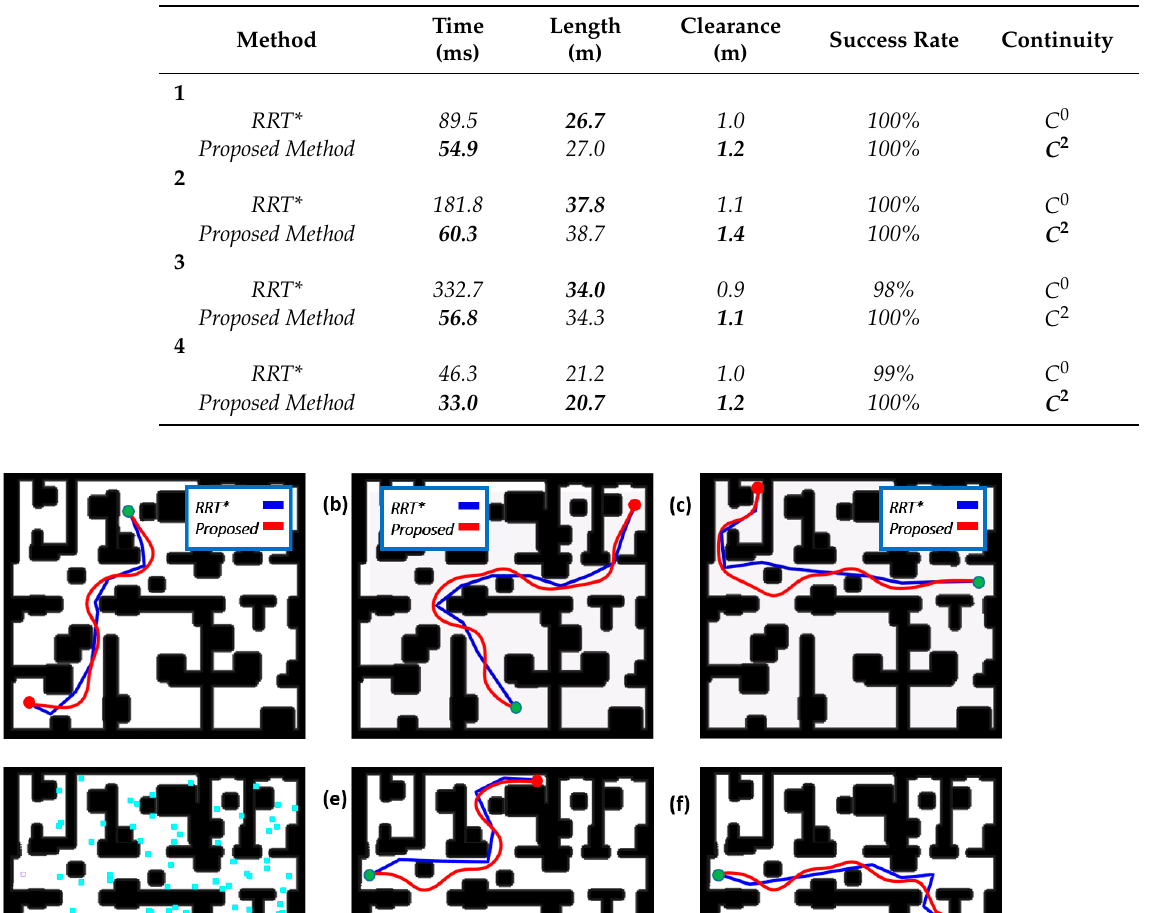
Table 4. Experimental data of different path planning methods.